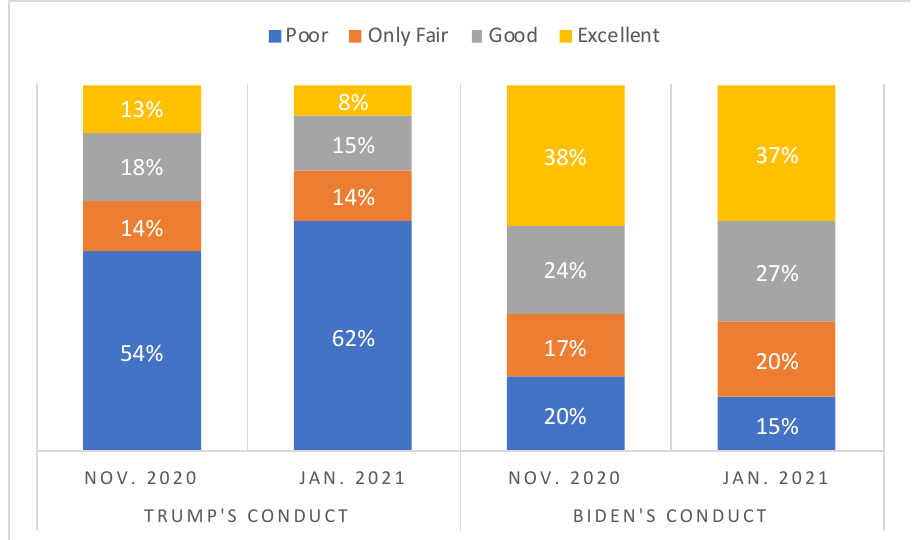
Figure 9. Evolution of the evaluation of Trump’s and Biden’s behavior after the presidential election. Source: Own elaboration from Pew Research’s American Trend Panel (2021).